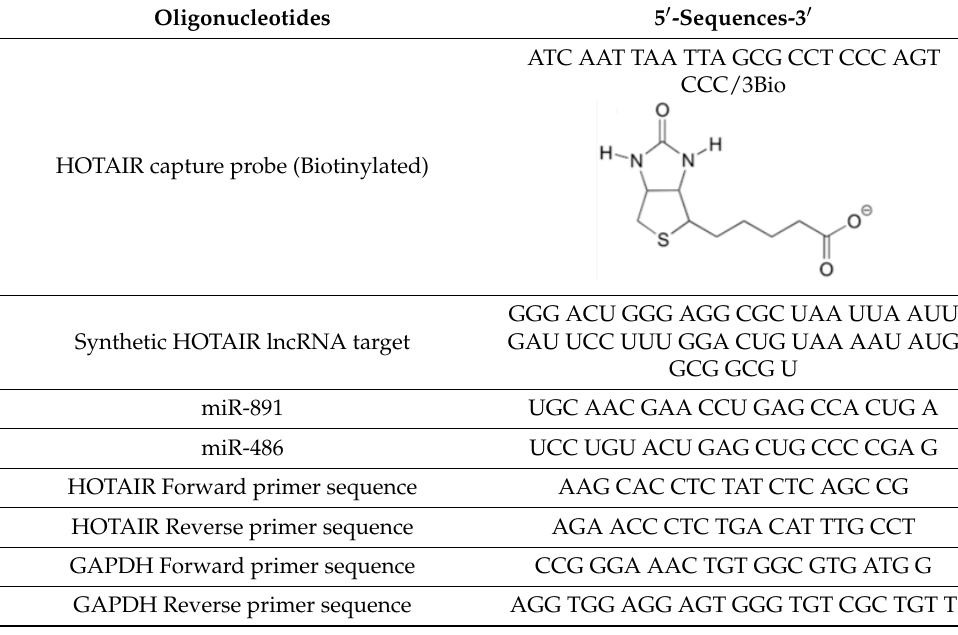
Table 1. Sequences of DNA/ RNA nucleotides used in 5 (cid:48) to 3 (cid:48) orientation. Oligonucleotides 5 (cid:48) -Sequences-3 (cid:48)